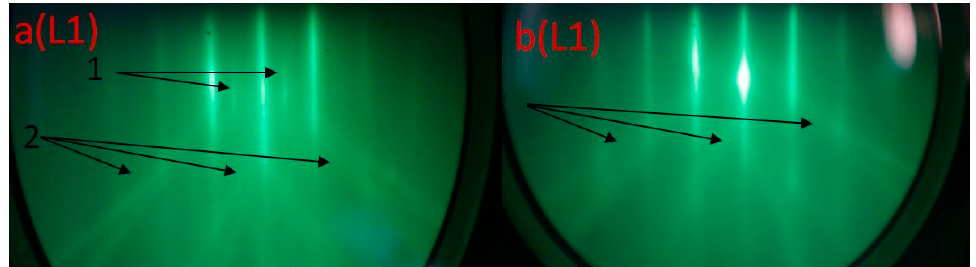
Figure 8. RHEED images taken for region L1: ( a ) after 20 s of irradiation and ( b ) after 1 min of irradiation.